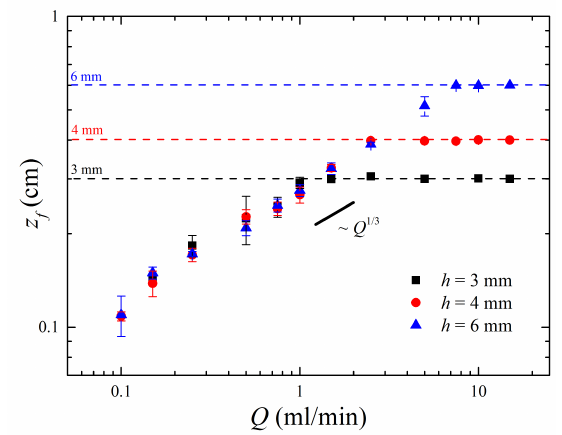
Figure 2. The depth to which grains are mobilised as a function of flow rate Q for various channel heights h . The dashed lines represent the full channel height h for each data